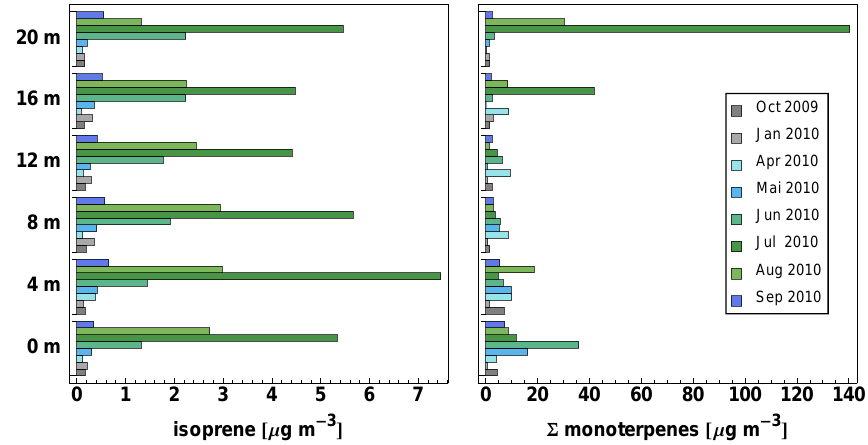
Fig. 3. Isoprene and total monoterpene concentrations measured in ambient air throughout the forest canopy and seasons. The sum of monoterpenes includes α -thujene, α - and β -pinene, camphene, 1 3 -carene and limonene (see also legend Fig. 5).